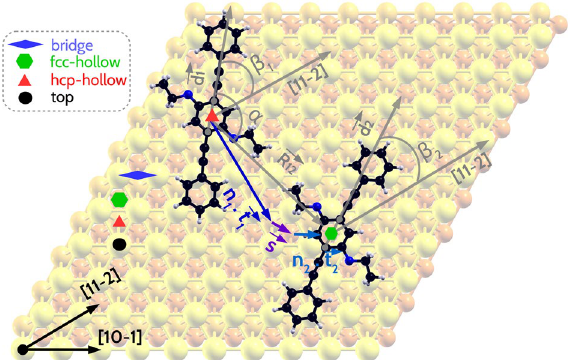
Figure 3. Formation of a molecular pair from the configurational space subgroup [hcp-m|fcc-m]: CPR of the first molecule is on a hcp-hollow site, of the second molecule on a fcc-hollow site. The in-plane rotation of the MB of the first molecule w.r.t [11-2] is β 1 = 54 between the centers of mass of the molecules corresponds to 3 between the direction vector the molecules amounts to 122.4